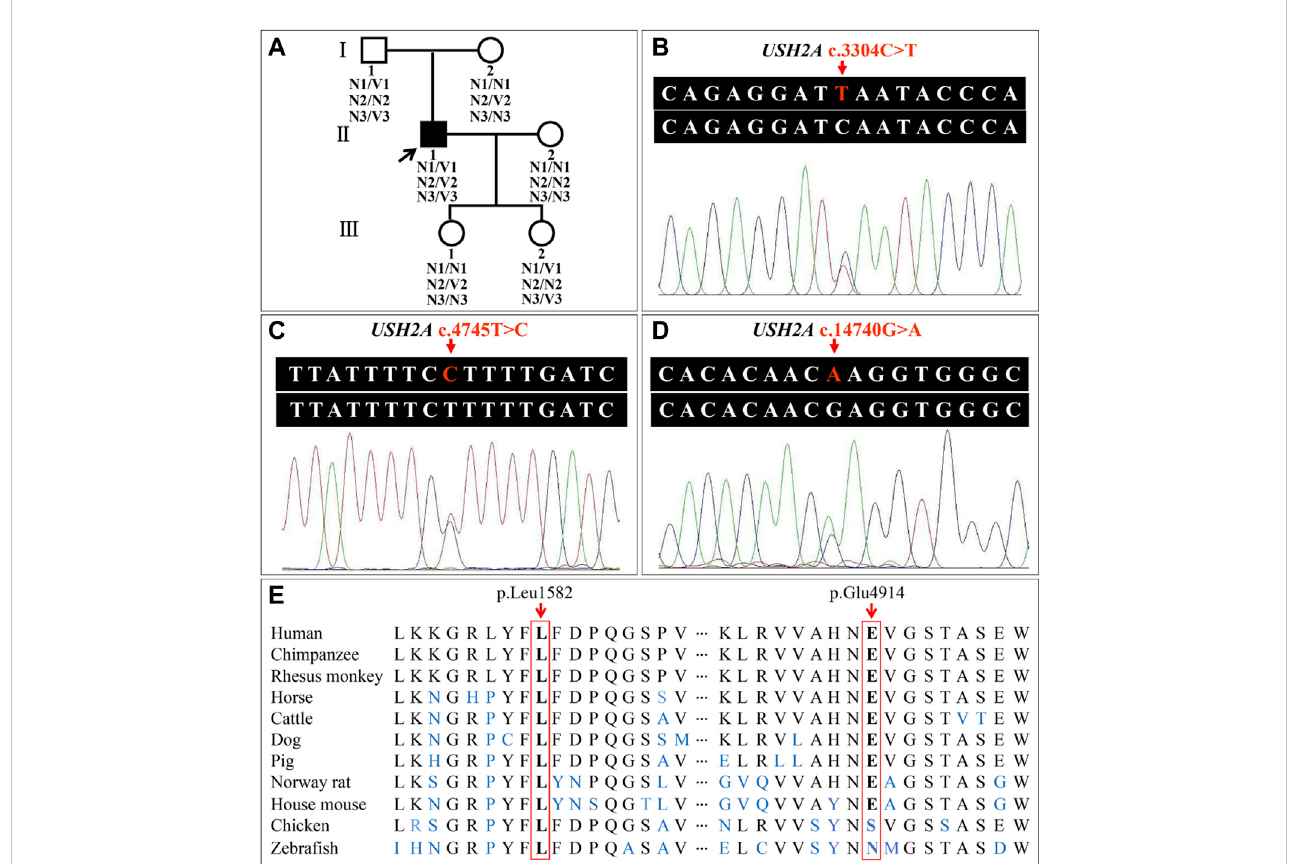
FIGURE 4 Pedigree of the family with autosomal recessive retinitis pigmentosa and analysis of the usherin gene ( USH2A ) variants. (A) Pedigree fi gure. The squares andthecirclessymbolizemalesandfemales,respectively.Filledsymbolrepresentsthepatient,andemptysymbolsrepresentunaffectedmembers.Thearrow indicatestheproband.N1,allelewith USH2A c.3304C;V1,allelewith USH2A c.3304T;N2,allelewith USH2A c.4745T;V2,allelewith USH2A c.4745C;N3,allele with USH2A c.14740G; V3, allele with USH2A c.14740A. (B – D) Patient (II:1) with variants c.3304C > T, c.4745T > C, and c.14740G > A in the USH2A gene.